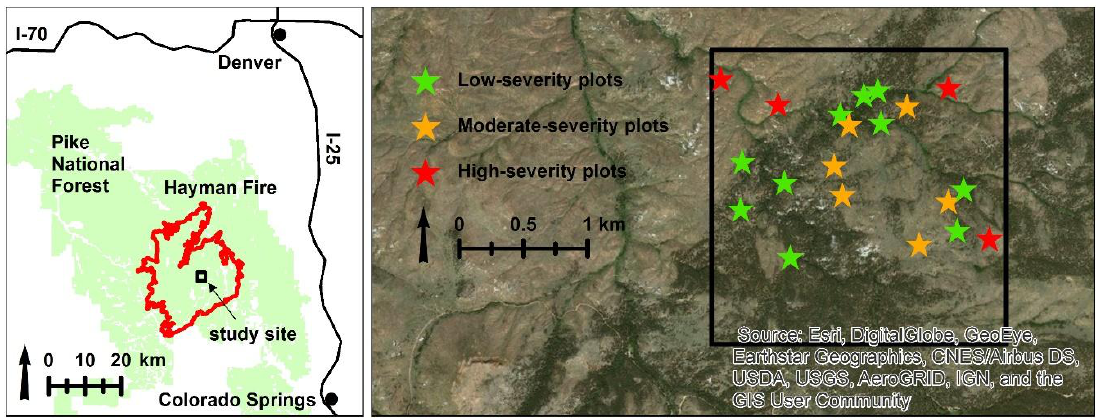
Figure 1. Location of the 400-ha study site within the Hayman Fire, Colorado, USA ( left ). Location and severity of the 20 0.1-ha plots within the study site, with post-fire aerial imagery in the background ( right ).